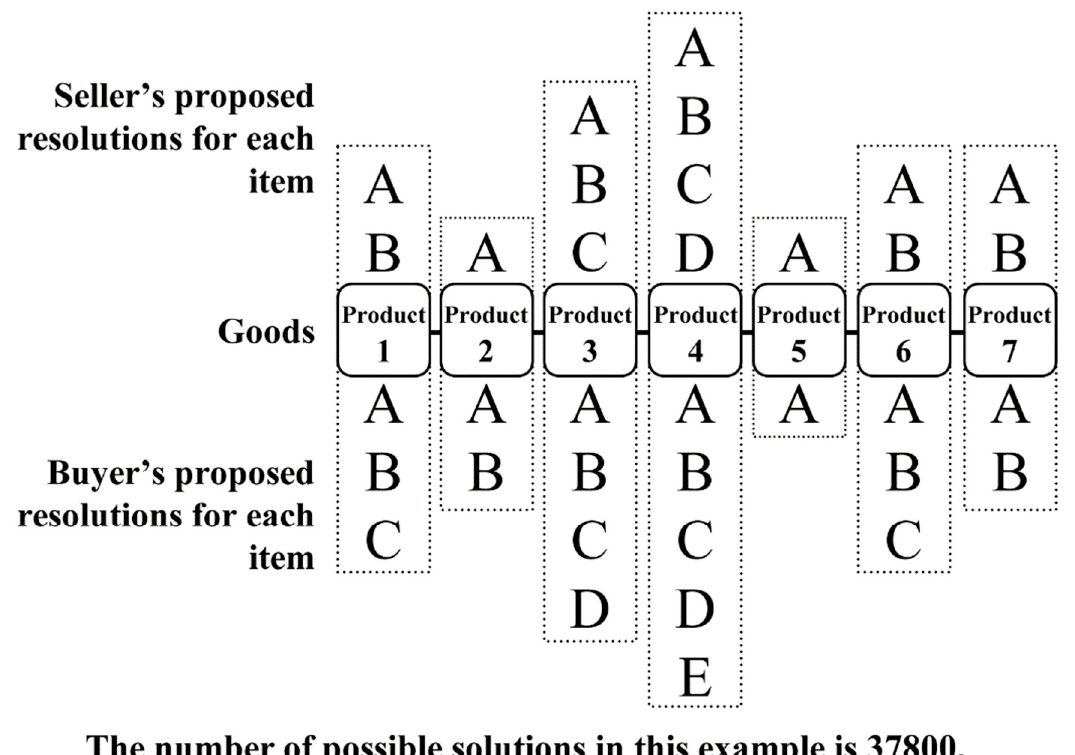
Figure 3. Suggestions for resolving a dispute (Phase 2 of the E-NeGotiAtion method). Assessment of the proposed resolution of the dispute (Phase 3): After the completion of the proposed variants of the solution, all the proposed options are presented to both parties. Each party evaluates the variants in terms of subjective advantage and subjective satisfaction (described in Section 4.1) on a scale from 0 to 10, while 10 is the most appropriate solution (Figure